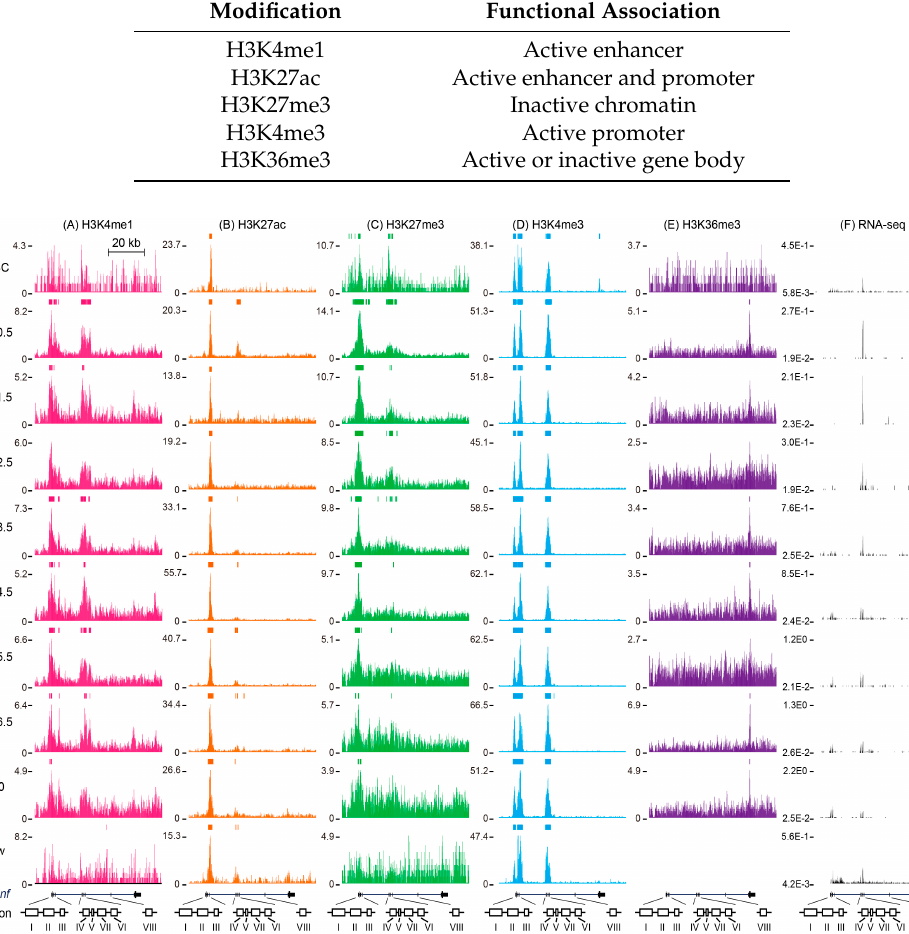
Table 1. Histone modifications and their functional associations.